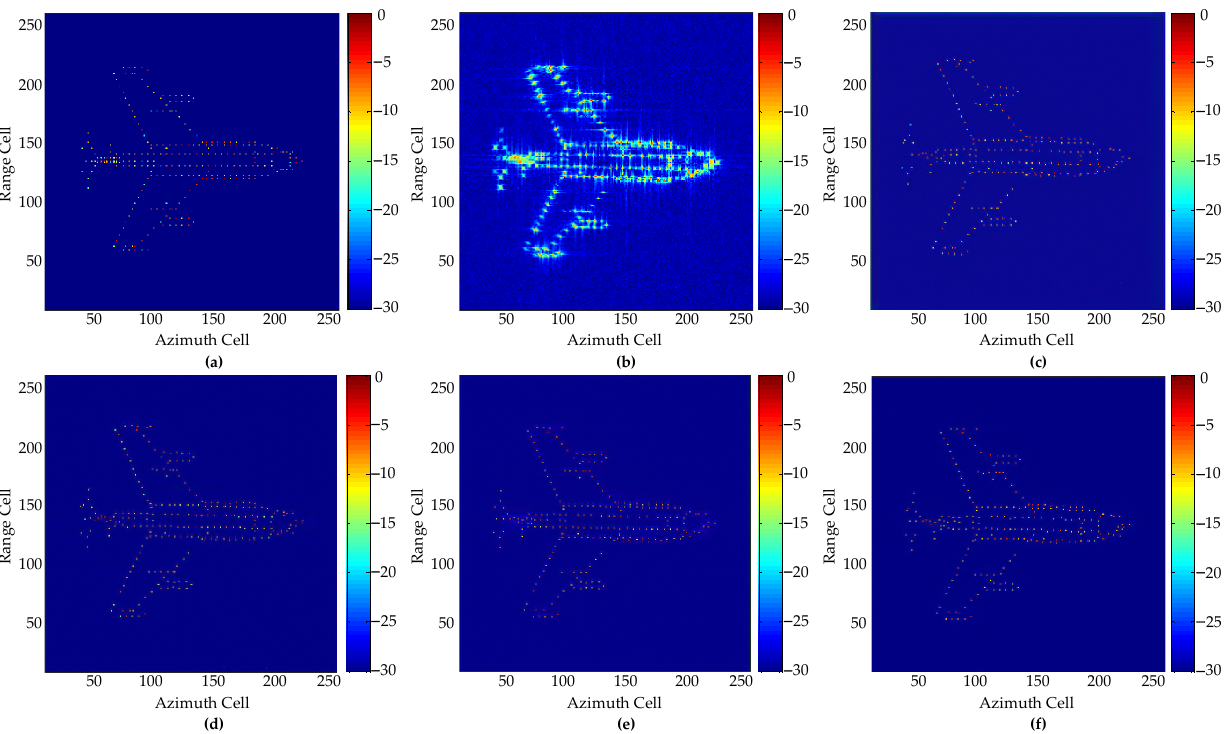
Figure 7. Imaging results of simulated aircraft at SNR = 2 dB: ( a ) Ground truth; ( b ) IFFT; ( c ) GAN1; ( d ) GAN2; ( e ) GAN3; ( f ) Proposed GAN.